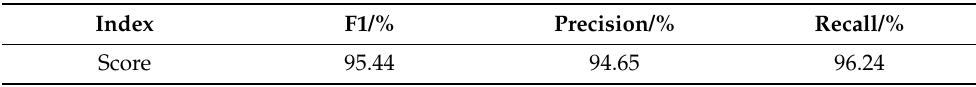
Table 3. Test results of grape fruit